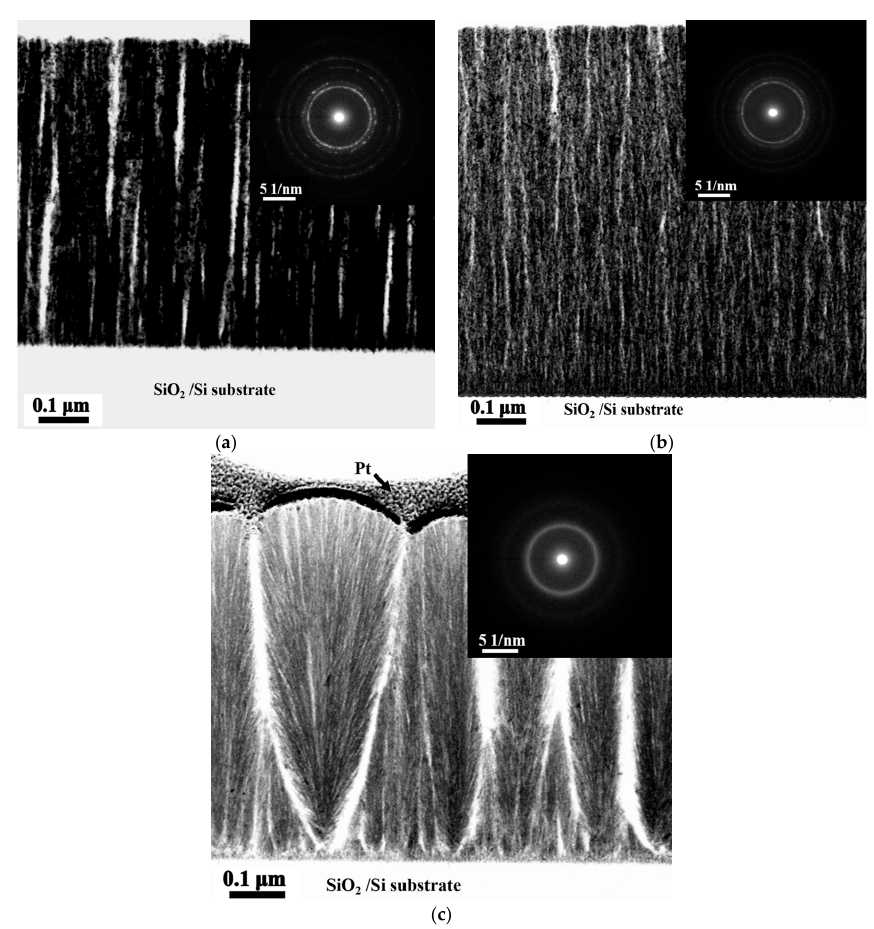
Figure 3. TEM BF images and corresponding SAD of as-deposited Ti x FeCoNi thin films: ( a ) Ti 0 film; ( b ) Ti 0.5 film; and ( c ) Ti 1.0 film.